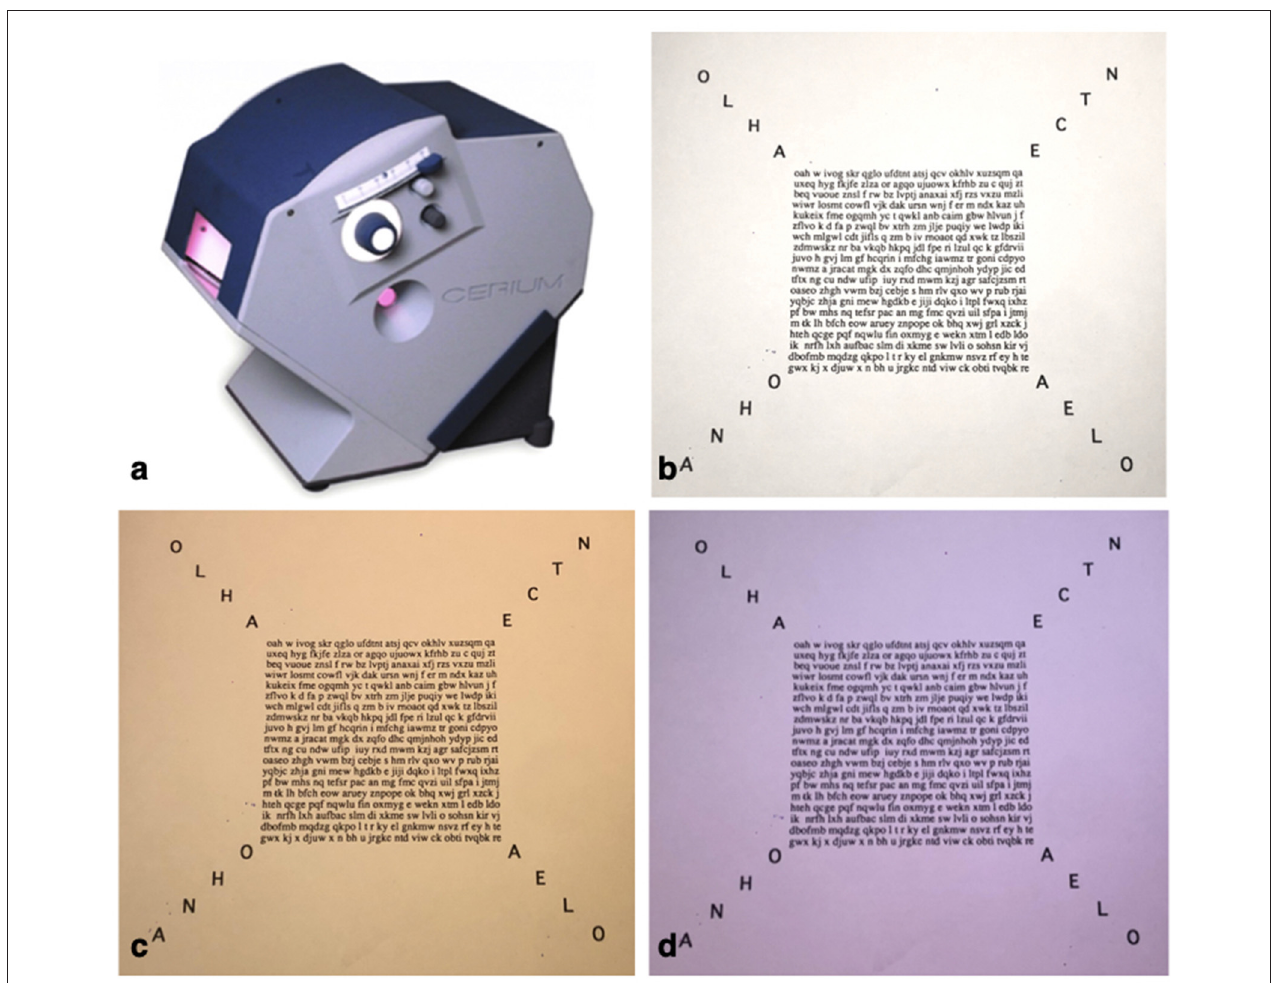
FIGURE 3 | Intuitive Colorimeter (a) , Crowded text used in neutral/daylight setting (b) and the most preferred yellow hue 79 deg (c) as well as least preferred blue-violet hue 276 deg (d) .